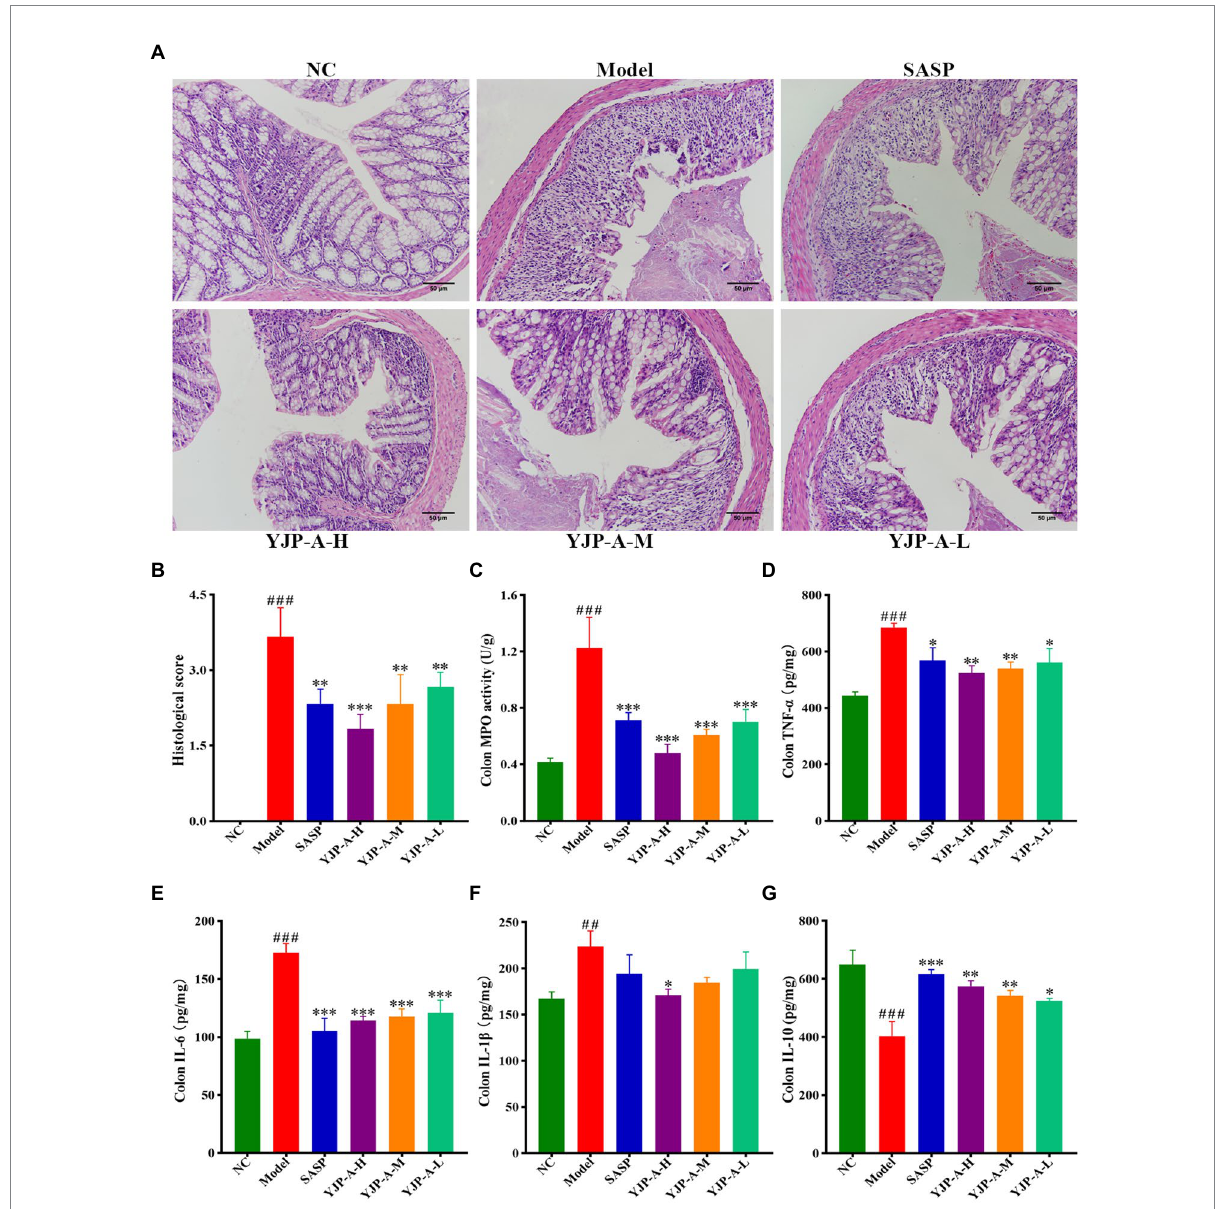
FIGURE 3 YJP-A ameliorates intestinal injury and inflammation response in UC mice. (A) Histopathology changes of each group in colon (200×). (B) Histological scores of colons. (C) MPO activity in colon. (D–G) Changes of colonic inflammatory cytokines levels, including TNF- α (D) , IL-6 (E) , IL-1 β (F) and IL-10 (G) . Data are expressed as the mean ± SEM, except for histopathological analysis n = 3 per group, the remaining analysis n = 5 per group. ## p < 0.01, ### p < 0.001 vs. NC group; * p < 0.05, ** p < 0.001, *** p < 0.0001 vs. model